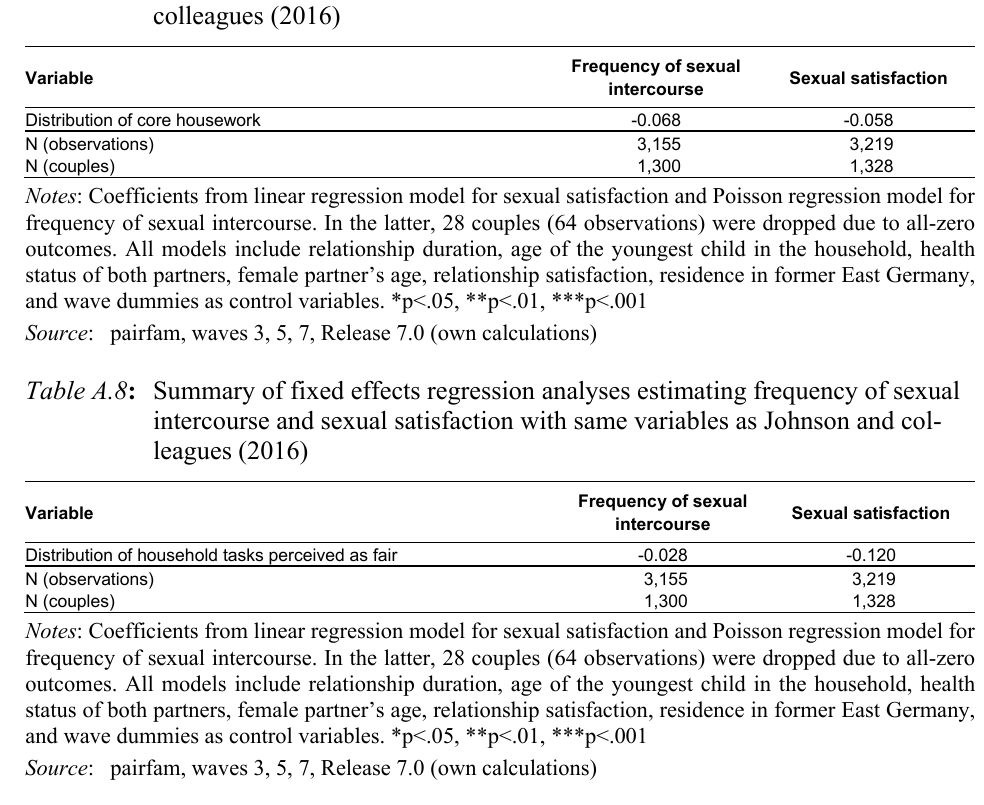
Table A.7 : Summary of fixed effects regression analyses estimating frequency of sexual intercourse and sexual satisfaction with same variables as Johnson and